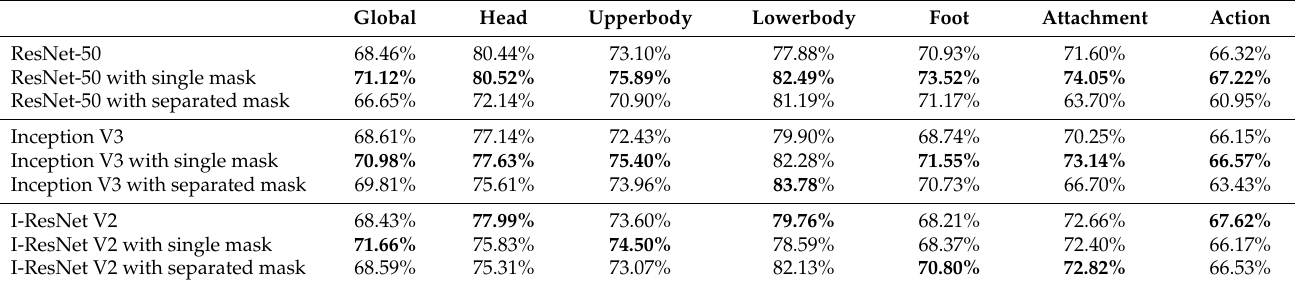
Table 6. The attribute classification performance in mA from RAP dataset.